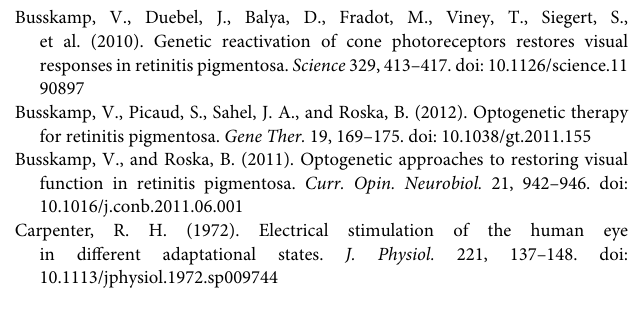
FIGURE 1 | Novel strategies for retinal stimulation. Photothermal stimulation left requires photo-absorber (e.g., black µ -particles) that absorb light energy and transfer it to heat, which in turn activates the cells in their near vicinity. Photovoltaic stimulation middle requires photoresponsive